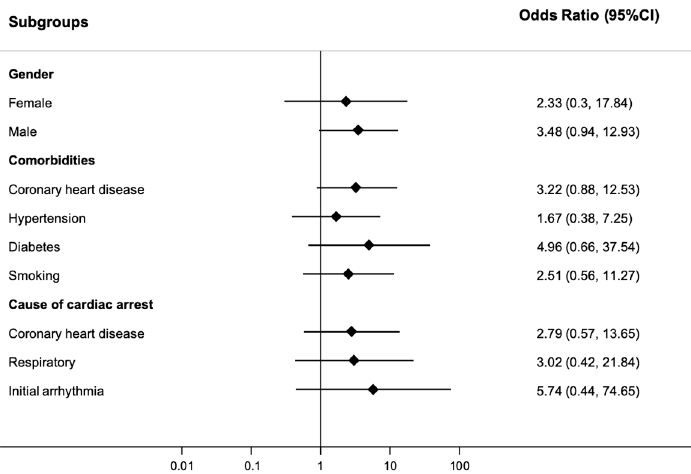
Figure 2. Forest plot for subgroups. Data is presented as odds ratio (OR) and 95% confidence interval (95% CI).